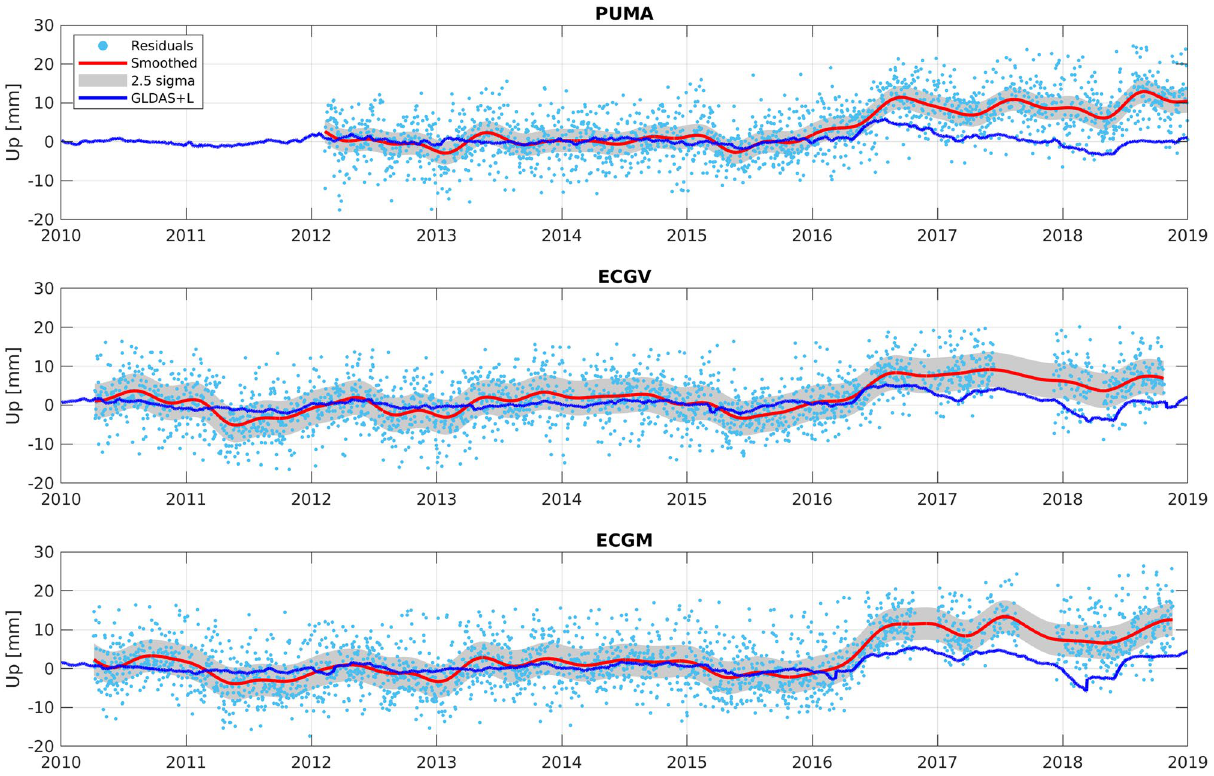
Figure 2. Vertical residuals for CGPS PUMA, ECGV, and ECGM including ground elastic response from the GLDAS + L model. A clear offset is visible after March 2016 when the CGPS time series show an additional uplift relative to the GLDAS + L